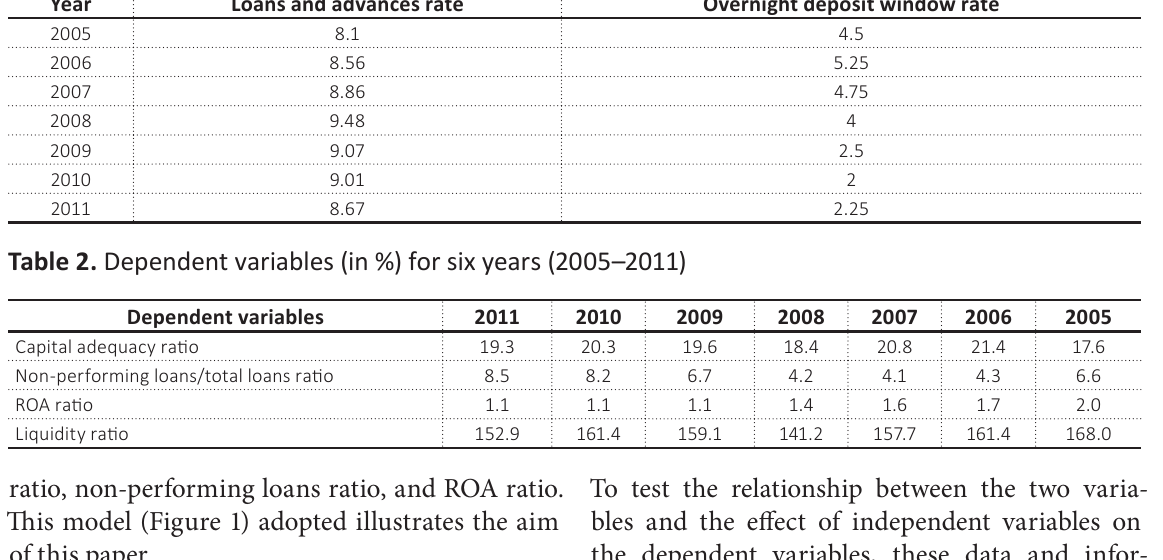
Capital adequacy ratio Liquidity